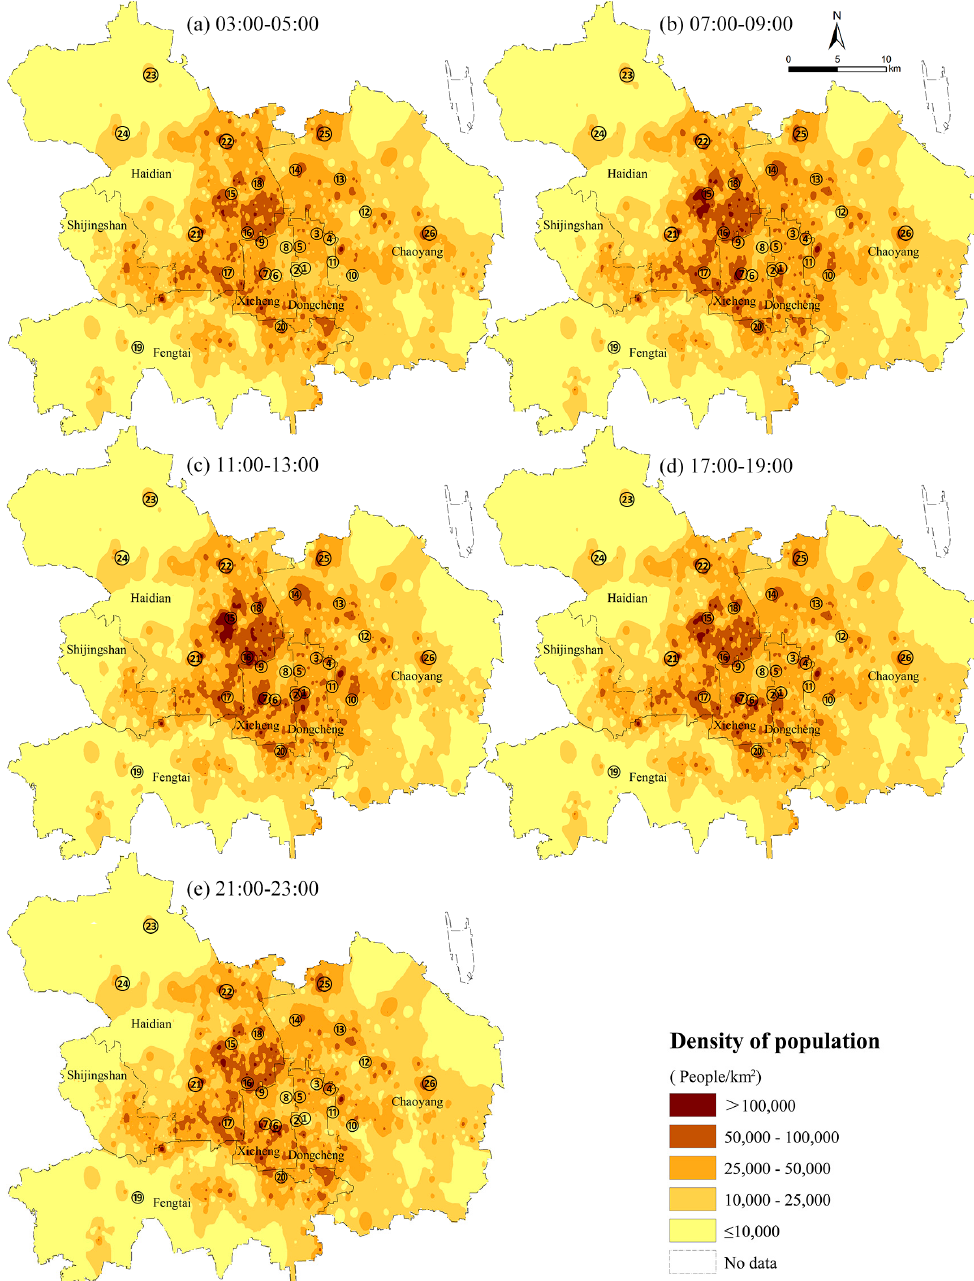
Figure 4. Spatial distribution of the dynamic population in the central area of Beijing. To make the spatial distribution clear, the IDW method was adopted. 21, Shijicheng; 22, Shangdi Information Industry Park; 23, Yongfeng High-tech Industrial Base; 24, Wenquan Science & Technology Park; 25, Laiguangying Culture Creative Industry Park; and 26, Dongba business area. No. 1 to No. 20 are the same as shown in Figure 3.